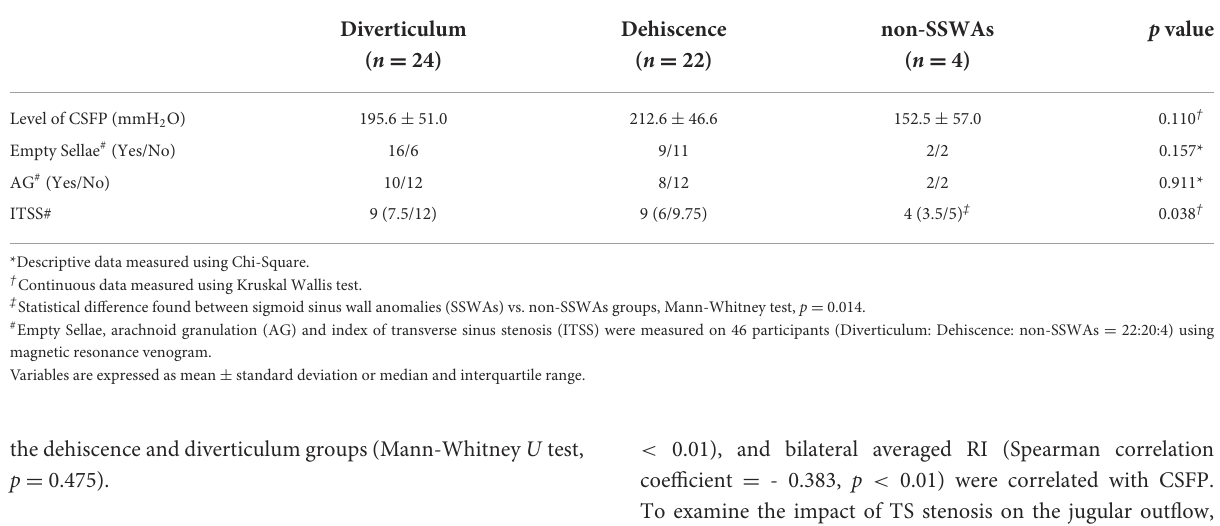
TABLE 3 Descriptive and continuous data of 50 study subjects characterized by diverticulum, dehiscence, and non-SSWAs groups.